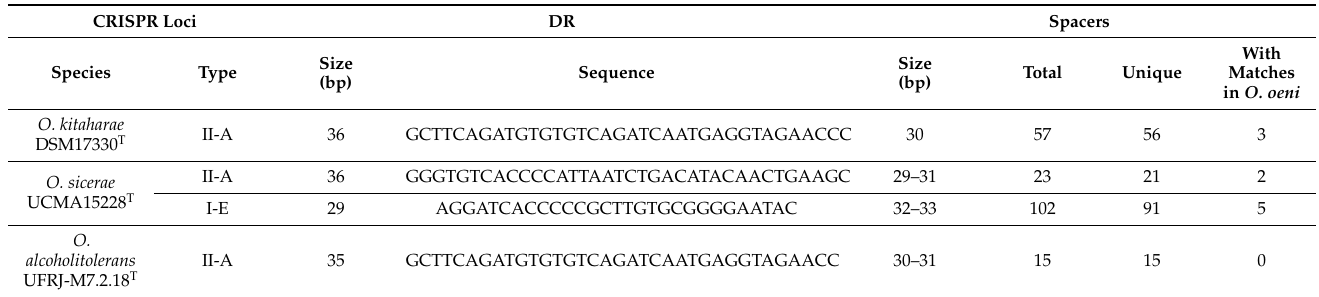
Table 1. Characteristics of CRISPR arrays in the Oenococcus